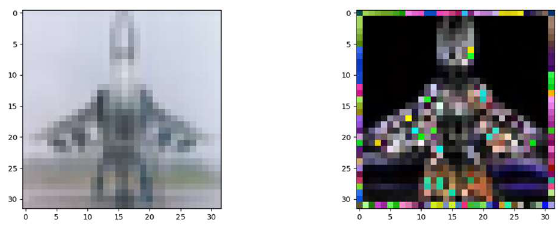
Figure 7. The original image and the texture image.